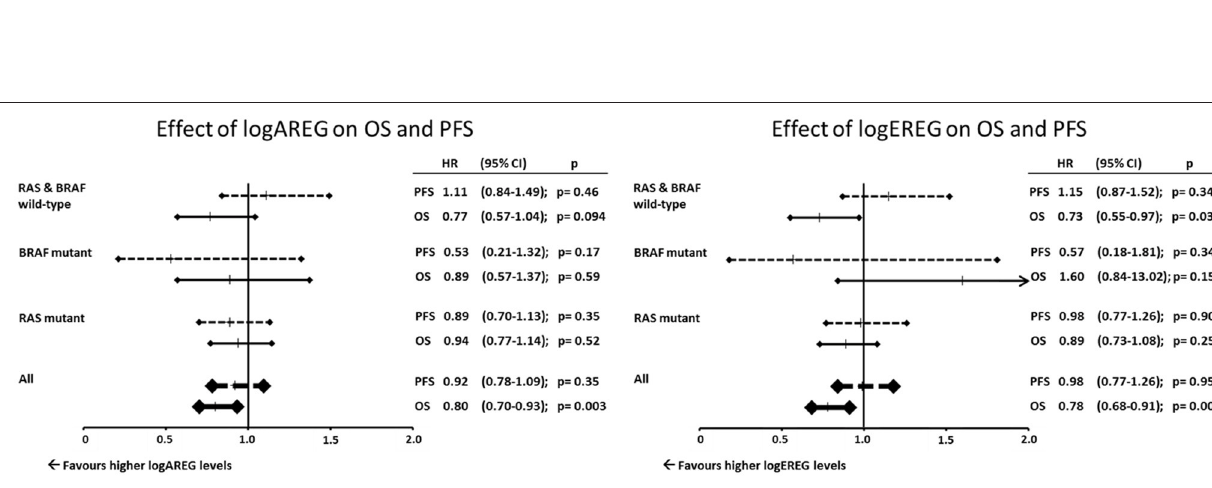
Frontiers in Oncology |